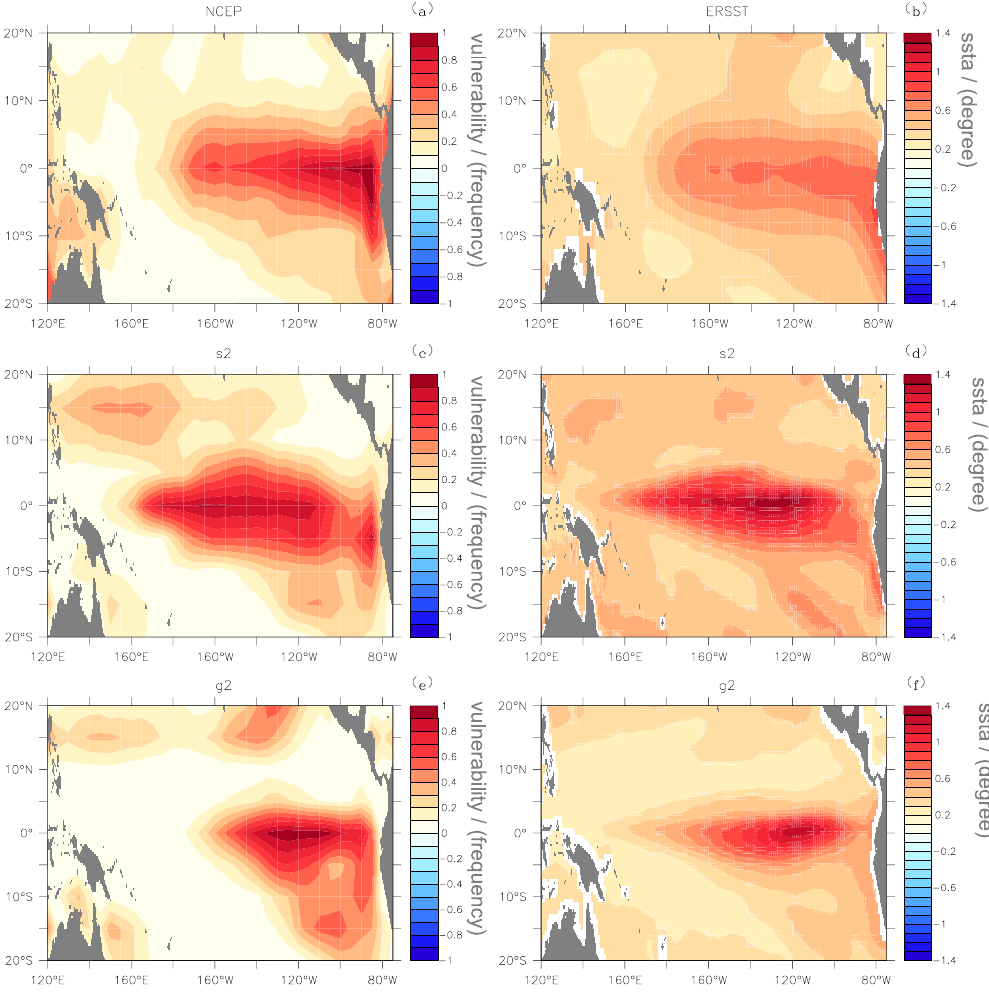
Figure 6. Spatial distributions of node vulnerabilities F i and the sea surface temperature (SST) anomalies. Right- hand column shows the SST anomalies, which were calculated by combining both the positive anomalies and negative anomalies (taking the absolute values). Left-hand column shows the node vulnerabilities of the SAT network. The nodes with higher frequency (chance) of being isolated are marked by dark color. The upper panel represents the results from reanalysis datasets (NCAR). The middle panel shows the results of FGOALS_s2, while the bottom panel gives the simulations from FGOALS_g2. Using reanalysis datasets, one can see good agreements in the regions with strong node vulnerabilities [panel (a)] and with large SST anomalies [panel (b)]. FGOALS_s2 succeeded in reproducing this consistency, but FGOALS_g2 failed. The figure is generated using Ferret (version6.9,